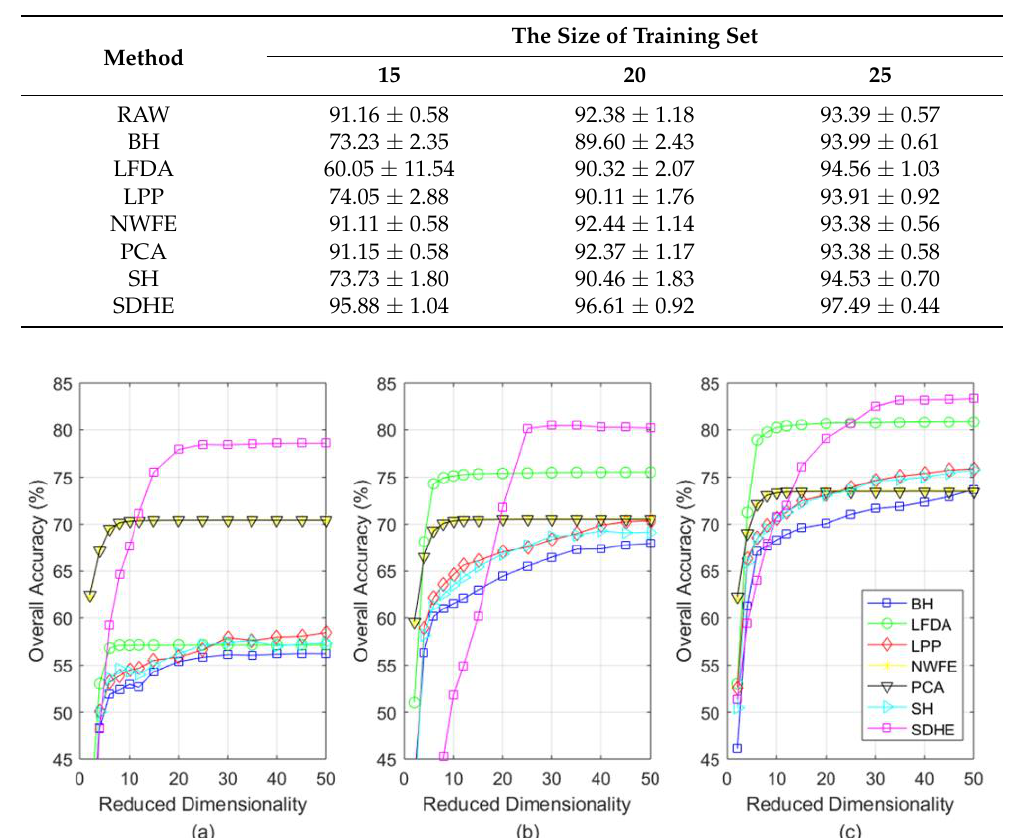
Table 9. Classification accuracy (%) at 30-dimensionality for the different sizes of training sets in KSC>.